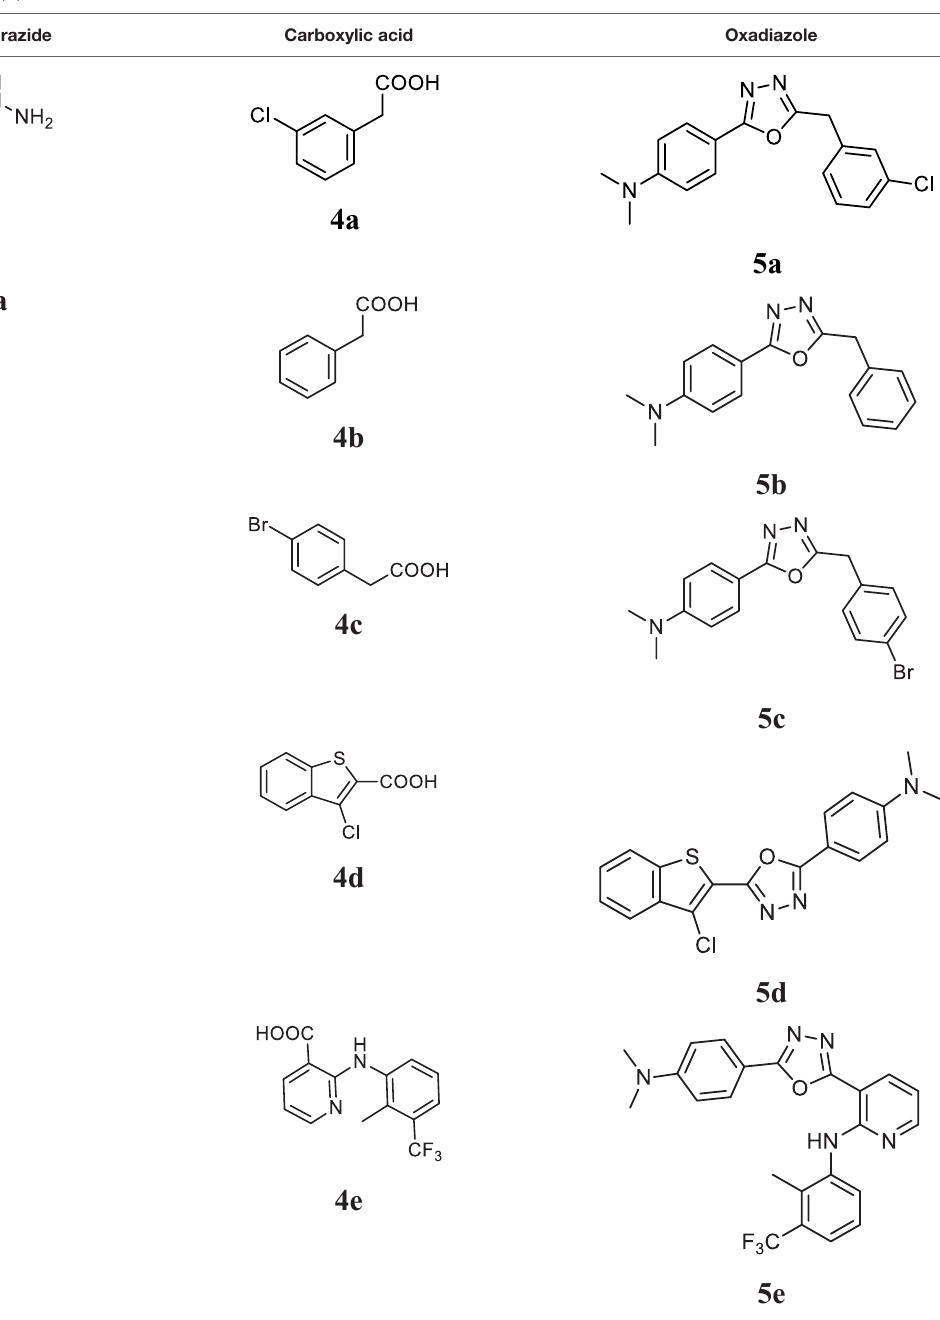
TaBle 1 | Library of newly synthesized